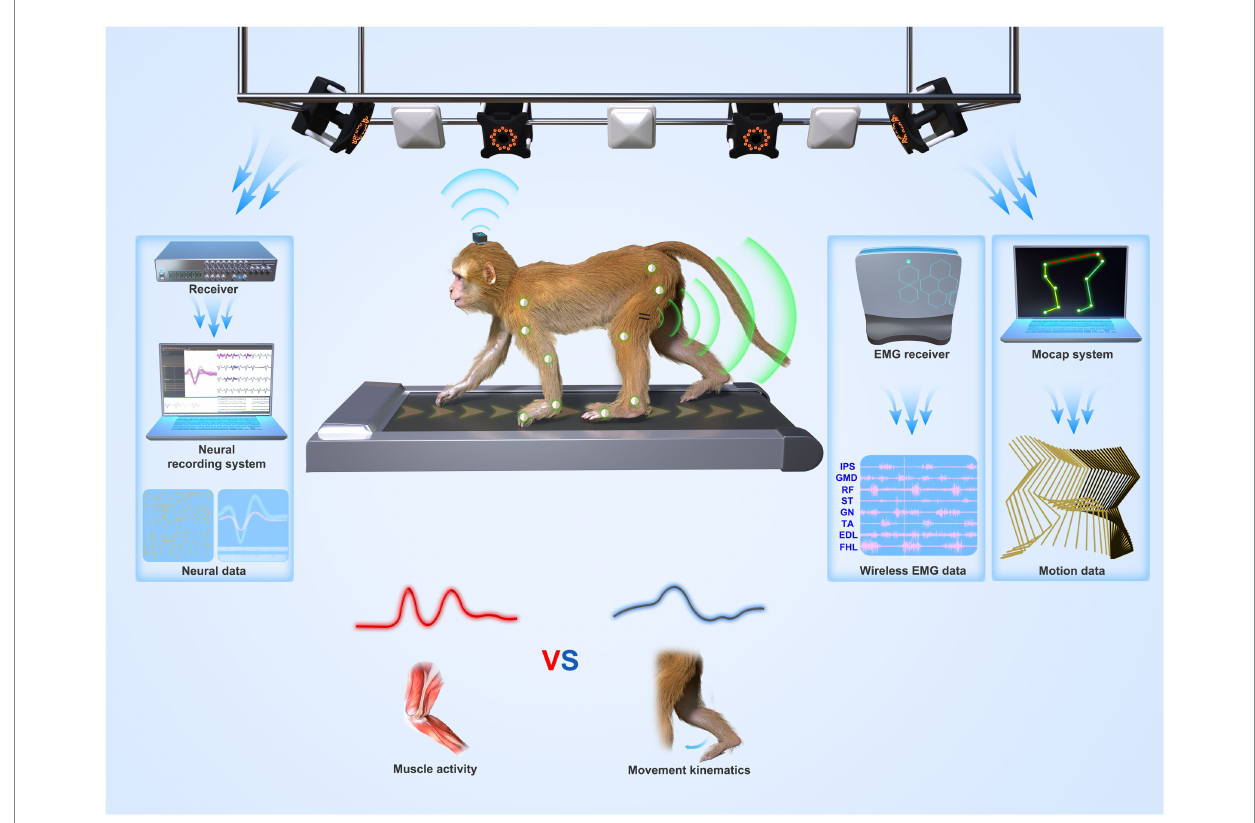
FIGURE 3 System overview of a suggested freely-moving (untethered) NHP model or paradigm. Wireless neural, EMG, and motion data from a monkey were recorded synchronously. The paradigm can be used to understand whether the motor cortex codes muscle activities (lower left panel) or movement parameters (lower right panel) during